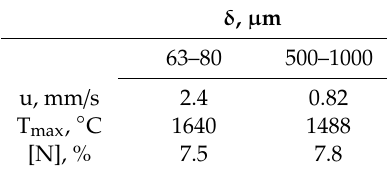
Table 1. Maximum temperature and burning rate of chromium in nitrogen.